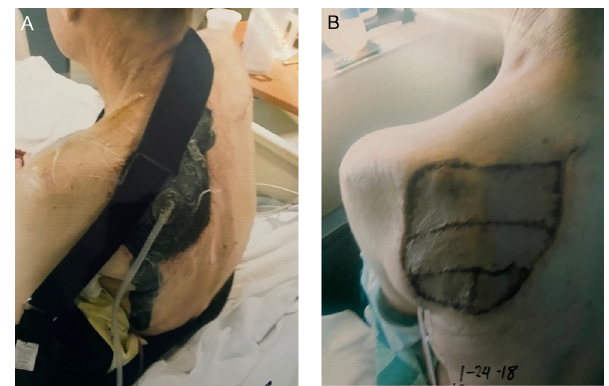
Figure 2. (a) Left periscapular region following extensive irrigation and debridement of the initial scapular lesion. A negative pressure wound therapy system can be seen placed in the defect created fol- lowing debridement. (b) Left periscapular region following exten- sive irrigation and debridement and split thickness skin grafting for final closure.